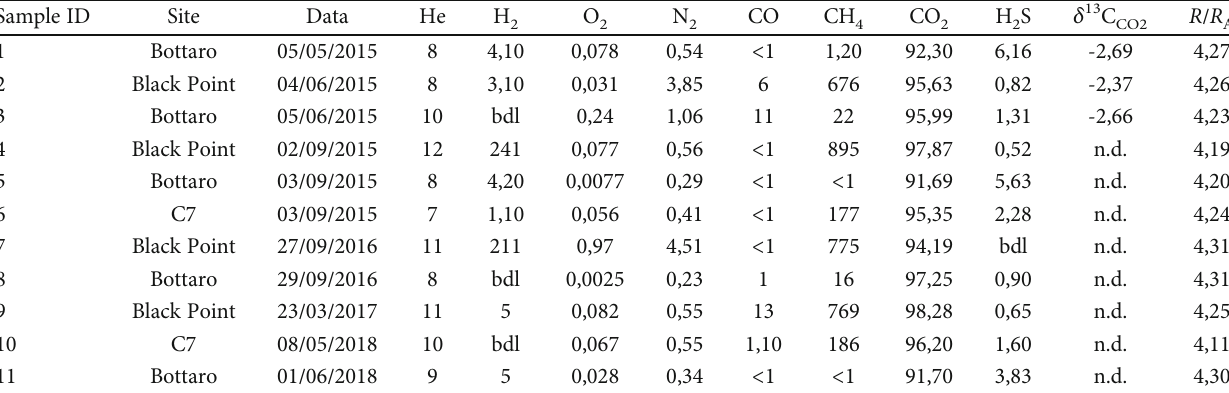
Table 1: Chemical and isotopic composition of the bubbling gases. CO vol.